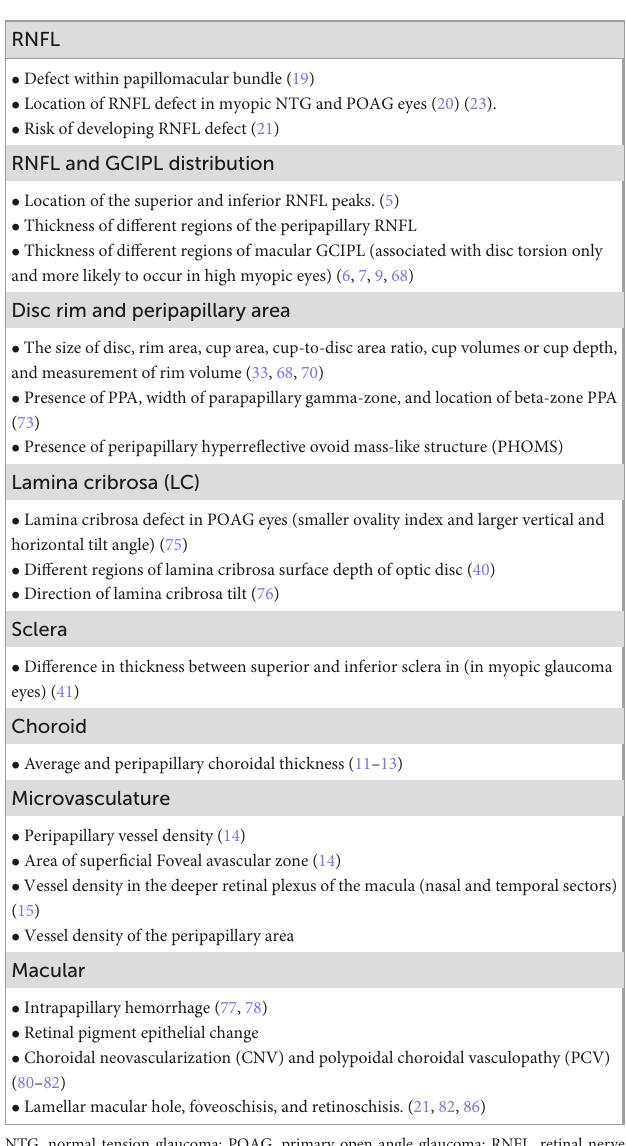
TABLE 1 A list of the associations between myopic tilted disc (disc tilt and disc torsion) and myopic-related structural changes. RNFL